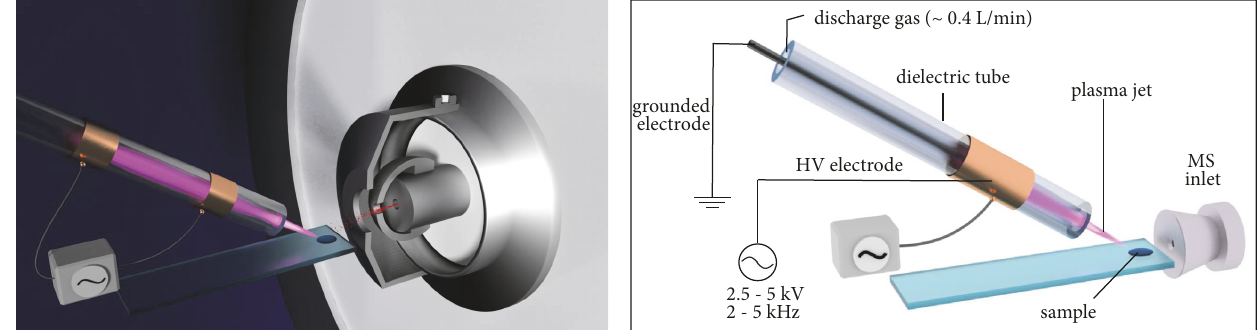
Figure 6: Physical appearance of the LTPI-source: schematic drawing of the plasma directed onto a